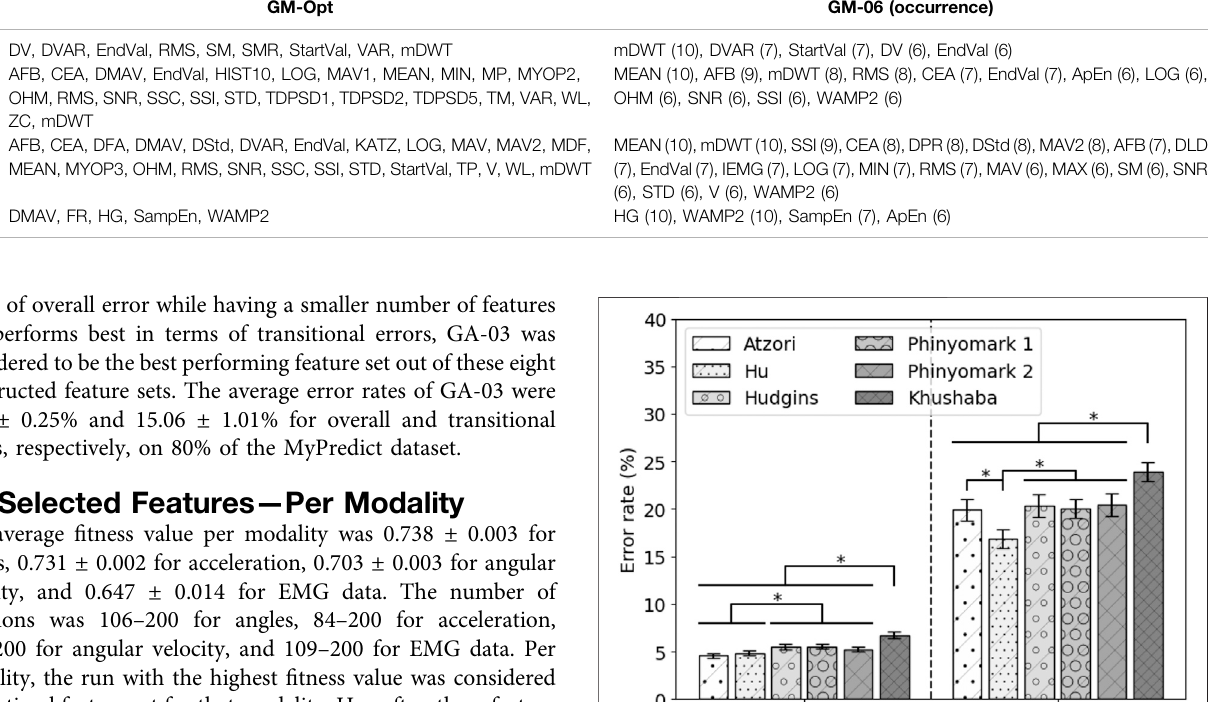
TABLE4| SelectedfeaturesofGM-OptandGM-06foreachdatatype.TheoccurrenceofthefeaturesisgivenaftereachfeatureforGM-06.Featurede fi nitionscanbefound in Table 1 . Type